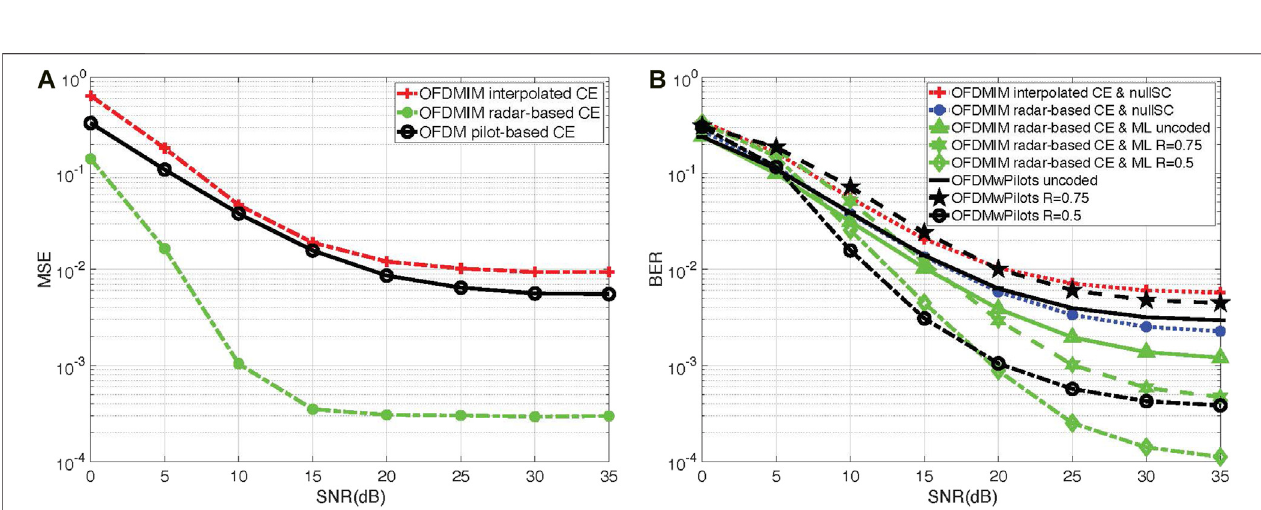
FIGURE6| Performanceanalysisinthepresenceoffourtargetswithvelocities[0,14.9,21.2,30.6](m/s)anddistances[29.3,127.3,225.3,323.3](m). (A) MSEvs. SNR and (B) BER vs. SNR.